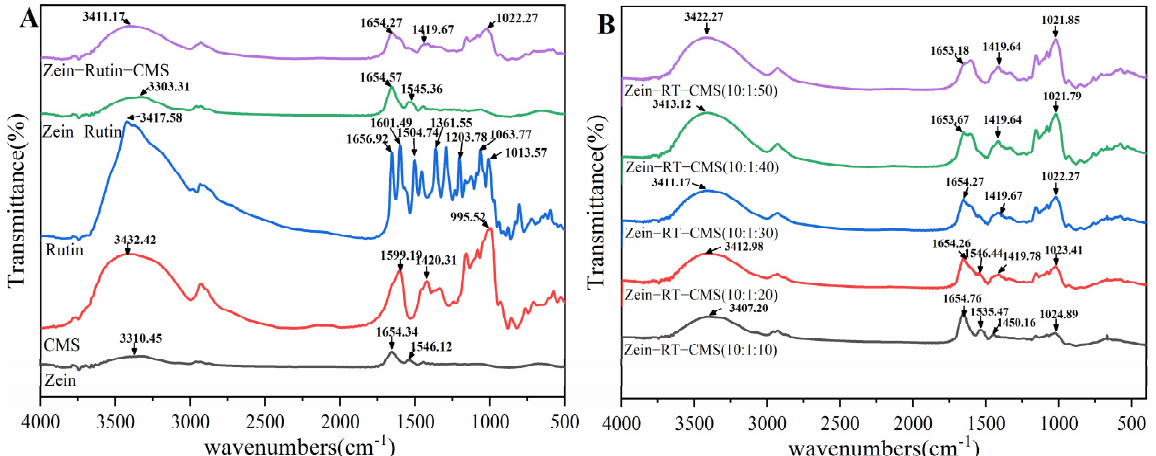
Figure 3. FTIR: ( A ) Comparison of spectrum among zein, CMS, RT, zein–RT, and zein–RT–CMS nanoparticles; ( B ) Spectrum of zein–RT–CMS nanoparticles at different levels of CMS. From Figure 3B, with the increase of CMS concentration (10:1:10–10:1:50), the charac- teristic peaks of O – H bands were 3407.2 cm − 1 , 3412.98 cm − 1 , 3411.17 cm − 1 , 3413.12 cm − 1